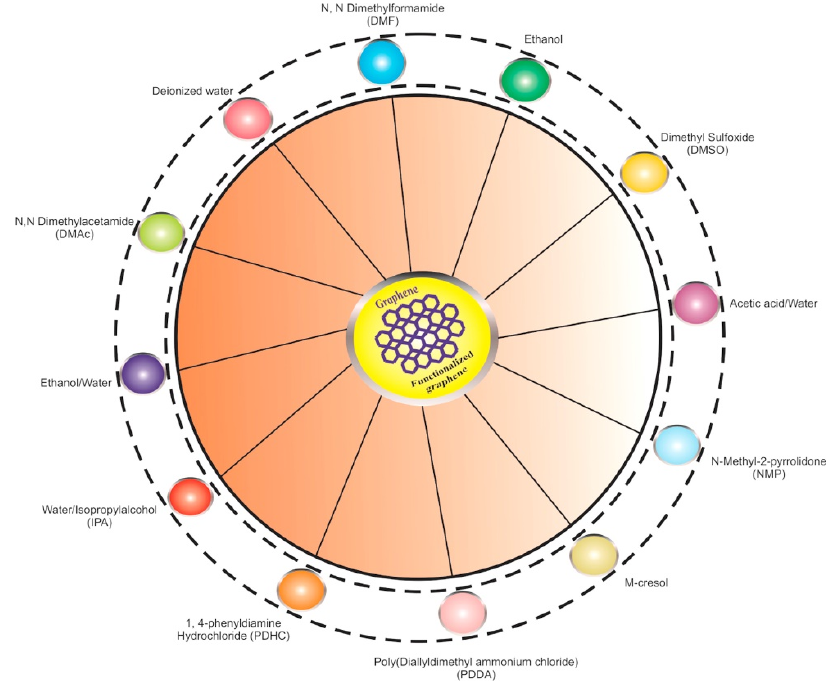
Figure 5. Graphene oxide-compatible solvents for polymer electrolyte membrane fuel cells (repro- duced from [167] with permission from Elsevier).